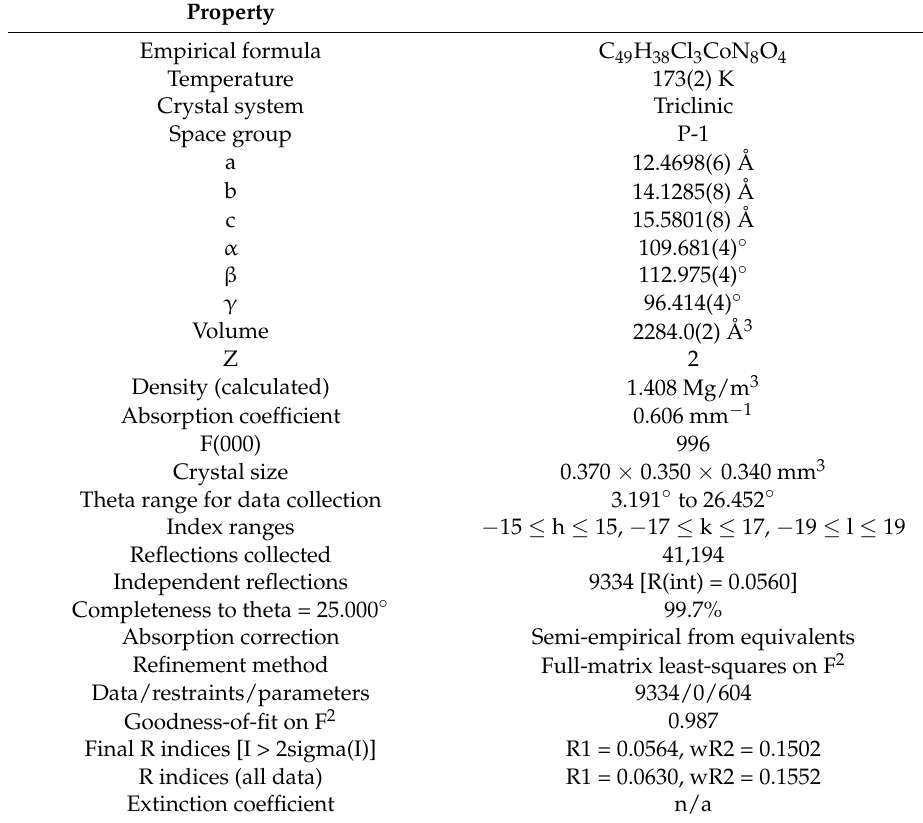
Table 3. Experimental details of the crystal structure